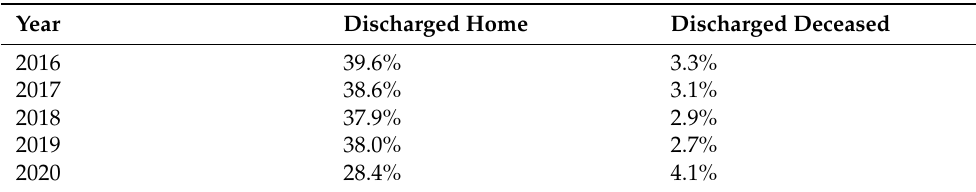
Table A2. Patients discharged home or deceased for a skilled nursing facility US Medicare claim set of specific diagnoses * (n = 9,365,419).